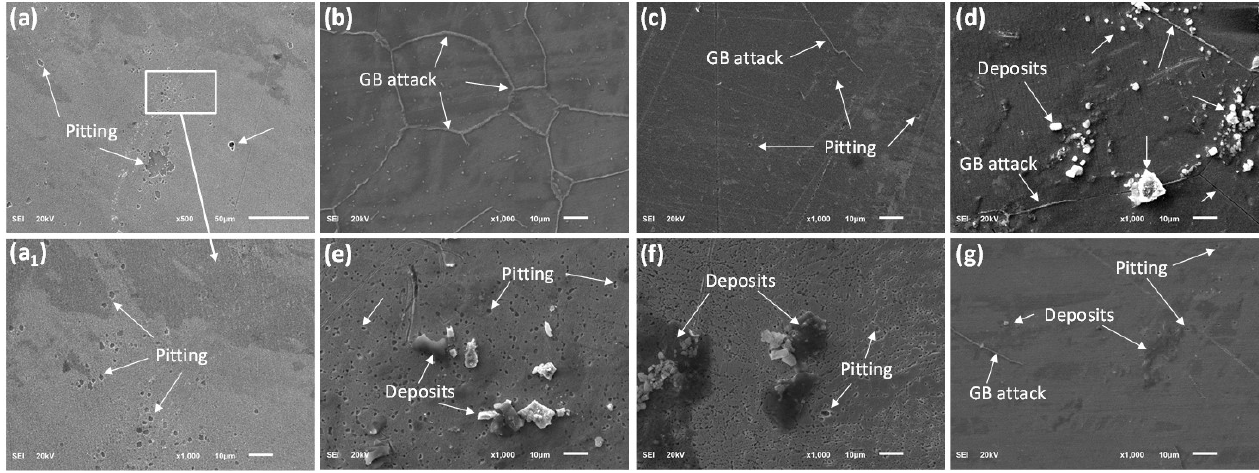
Figure 12. SEM analysis of the exposed area to corrosion in 3.5% NaCl solution after 1 h for samples ( a , a 1 ) A29, ( b ) T30, ( c ) T60, ( d ) T120 (or AT12), ( e ) AT10, ( f ) AT11 and ( g ) AT13